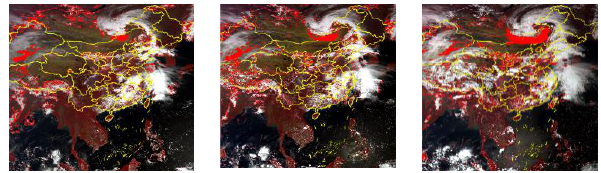
Figure 4 . The unsupervised classification image of on May 5, 2016. From left to right, they are 3:00, 5:00, 7:00UTC.